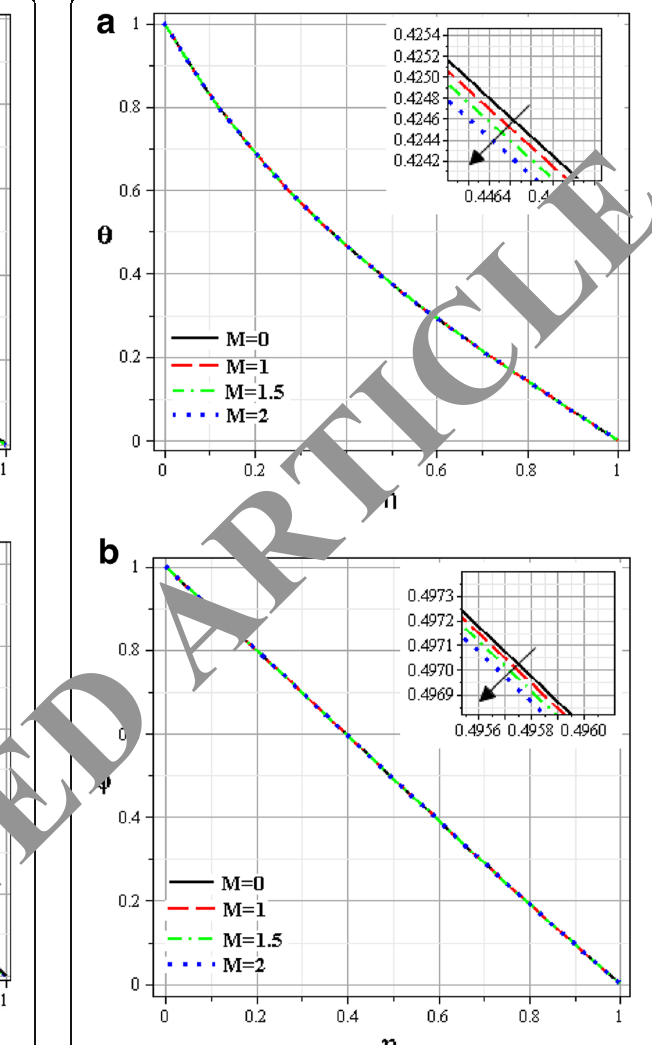
Fig. 7 a Effect of Nt parameter on temperature distribution when M = 1, A = 1, Le = 1, S = 1, Nb = 1, Pr = 6.2. b Effect of Nt parameter on concentration distribution when M = 1, A = 1, Le = 1, S = 1, Nb = 1, Pr = 6.2